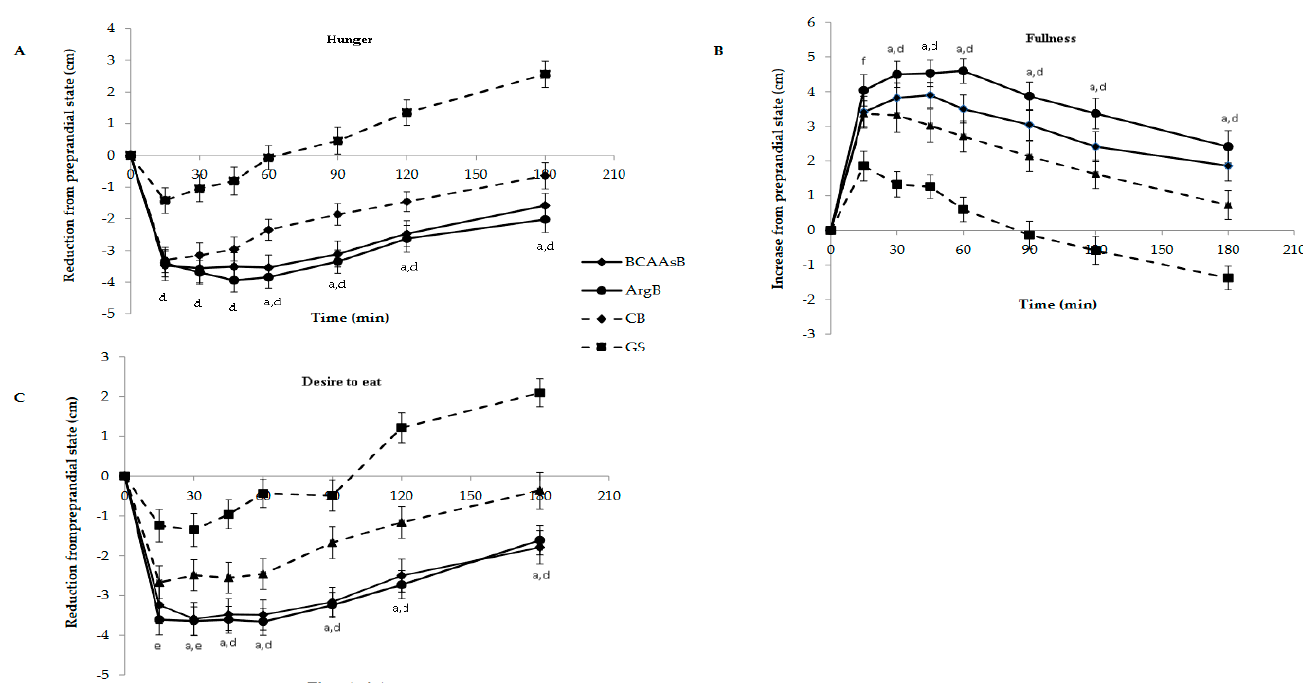
Figure 4. Mean subjective appetite rating differences from preprandial values of hunger ( A ), fullness ( B ) and desire to eat ( C ) of subjects after ingestion of the four test meals. Values are expressed as mean ± SEM ( n = 30). a p < 0.05 between ArgB and CB, d p < 0.05 between GS and ArgB, BCAAsB, CB, e p < 0.05 between GS and BCAAsB, ArgB. f p < 0.05 between GS and ArgB.